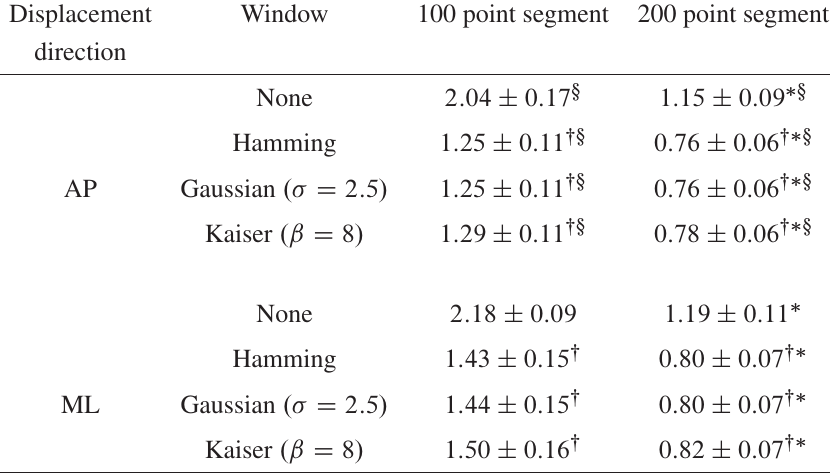
Table 1. Mean frequency computation for AP and ML